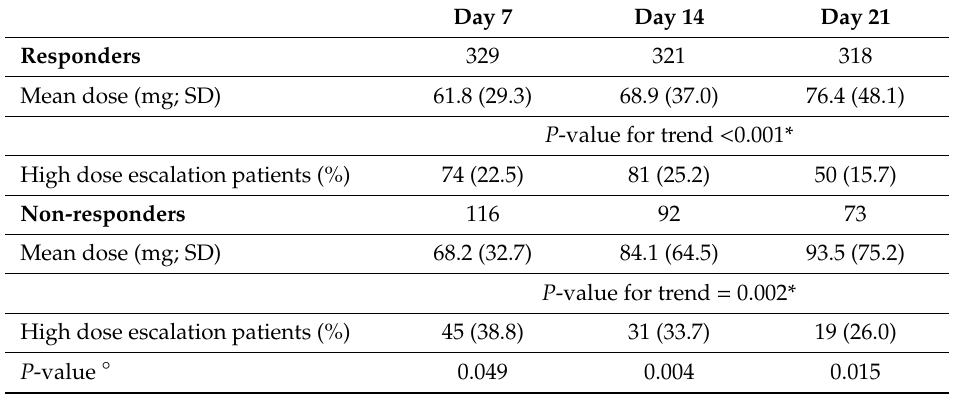
Table 4. Dose escalation according to analgesic response over time among 498 cancer patients.